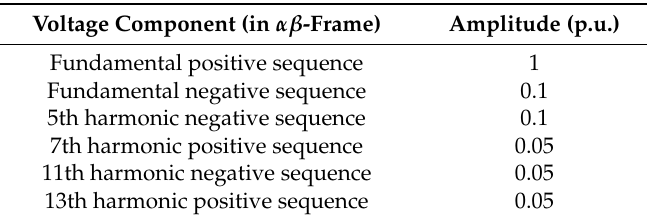
Table 3. Parameters of grid voltages.